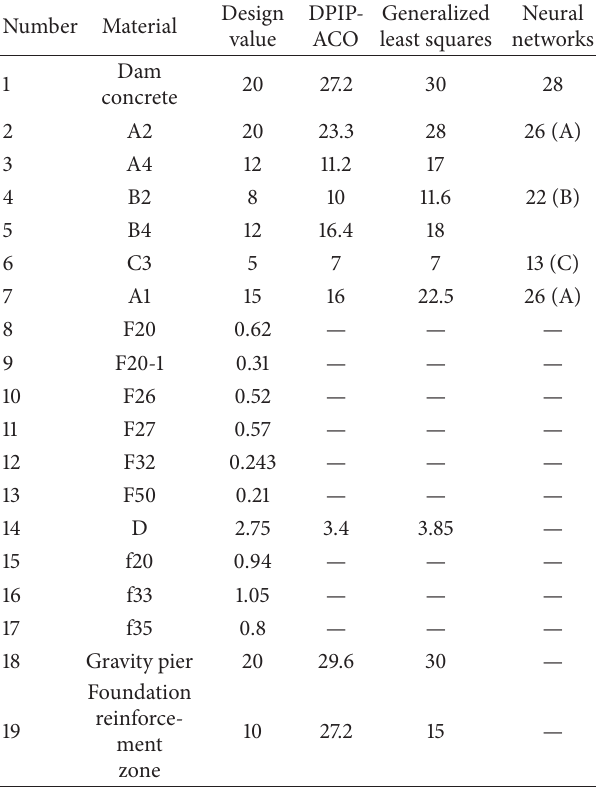
Table 2: The elastic modulus inversion results using various feed- back methods (unit: